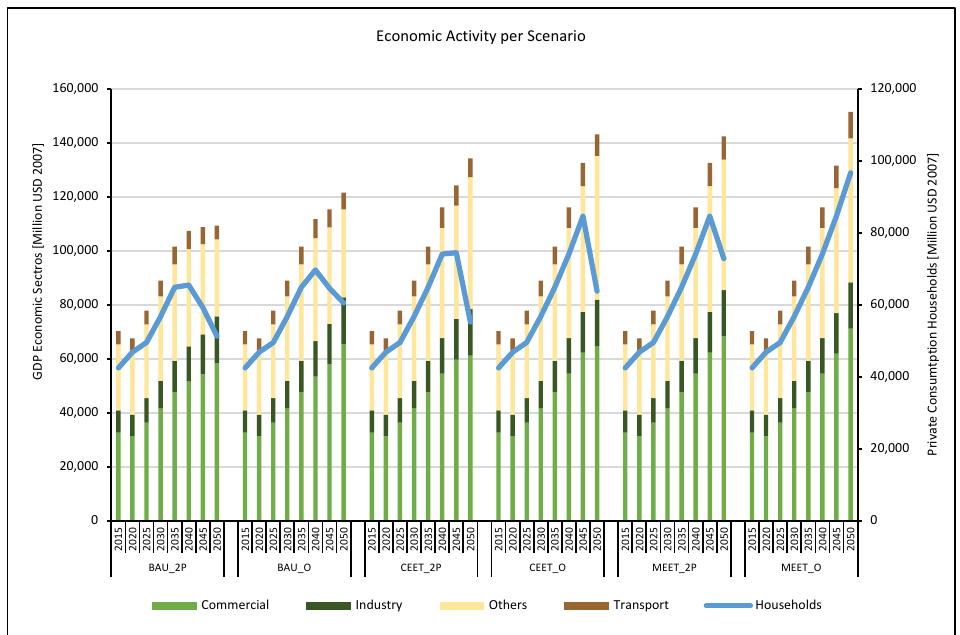
Figure 5. Evolution of economic activity per sector and scenario. For CEET scenarios, energy demand would peak by 2040 in CEET_2P and 2045 in CEET_O as consequence of the decrease of the energy supply. Compared to BAU scenar- ios, energy demand by 2050 would be between 0.6% to 1.9% lower. However, economic activity would be 14%–18% higher (Figure 5), and energy intensity would reduce 13.7%– 13.9% by 2050 in CEET scenarios (Figure 6). GDP would grow at an average yearly rate 2.3% for CEET_2P, and 2.5% for CEET_O. This indicates that even in a conservative case, the effects of the policies implemented towards energy transition would contribute to avoid economic collapse due to energy shortages.